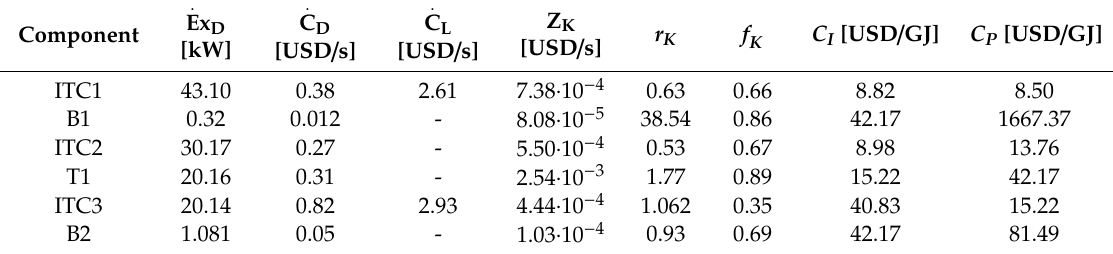
Table 7. Exergies destroyed by component, exergy destruction costs, di ff erence of relative cost, and exergo-economic factor by a system component